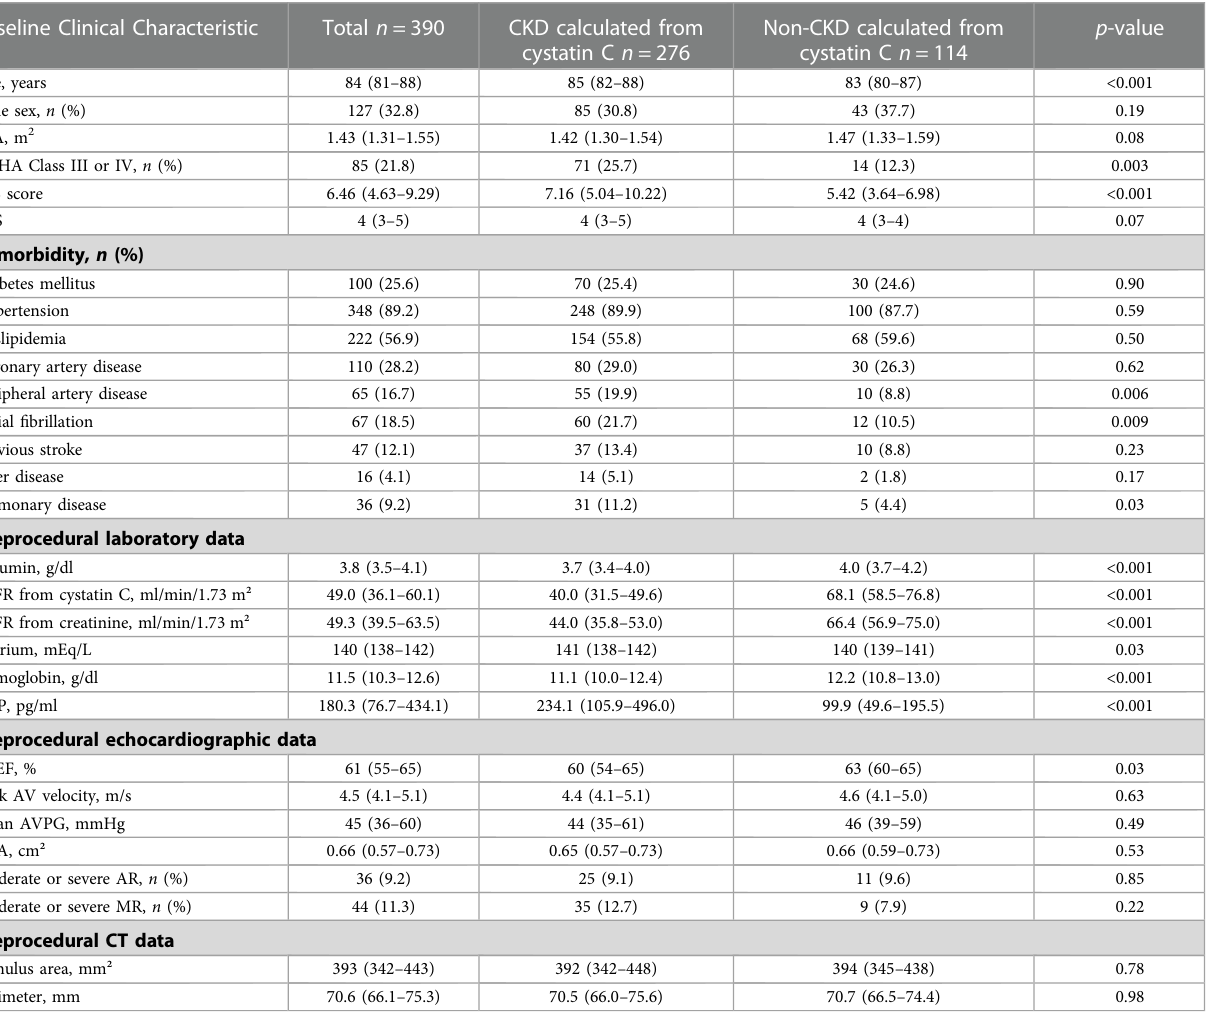
TABLE 1 Baseline clinical characteristic of study